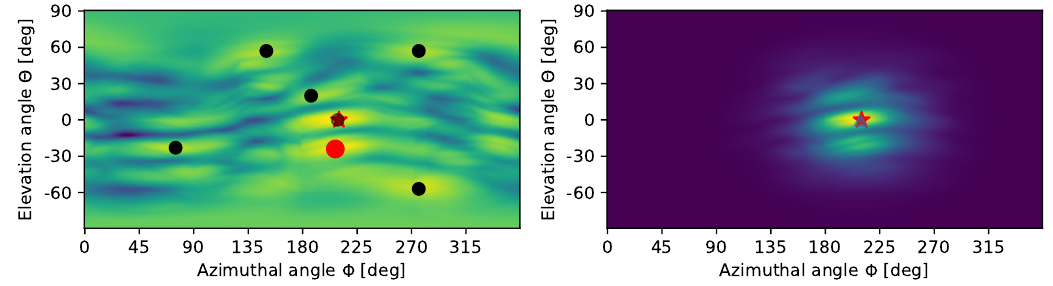
Figure 3. Intensity map at the output of the wideband delay-sum beamformer without ( left ) and with ( right ) TDoA multilateration-based masking. The latter mitigates the ambiguity and makes it possible to correctly estimate the location of the target (red star), while ruling out the strongest peak (red dot) which would correspond to a wrong target location. Yellow hues denote a stronger